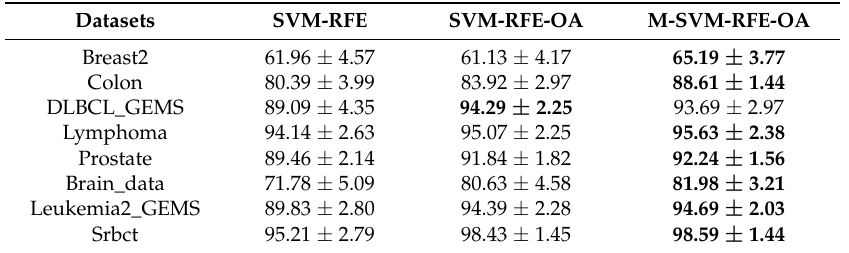
Table 2. Comparison in accuracy (%).